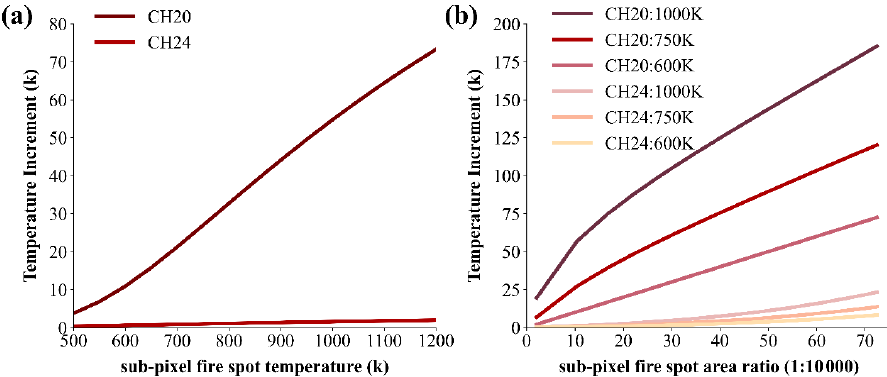
Figure 4. (a) Curves of FY-3D MERSI-II CH20 and CH24 brightness temperature increment with fire spot temperature (with fire spot area accounting for 0.1% of pixel area and background temperature at 290K). (b) Curves of FY-3D MERSI-II CH20 and CH24 brightness temperature increment with fire spot area (with fire spot temperature at 600, 750 and 1000K; background temperature at 290K; and the ratio of fire spot area to pixel area increasing from 0.01% to 0.4%). Table 3. Major rules for cloud pixel identification.